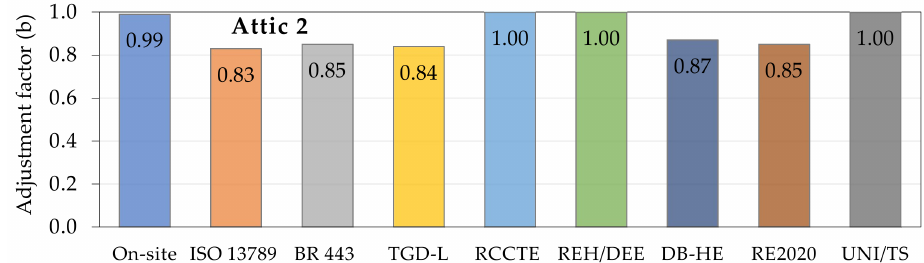
Figure 19. Comparison of the adjustment factor values (b) for Attic